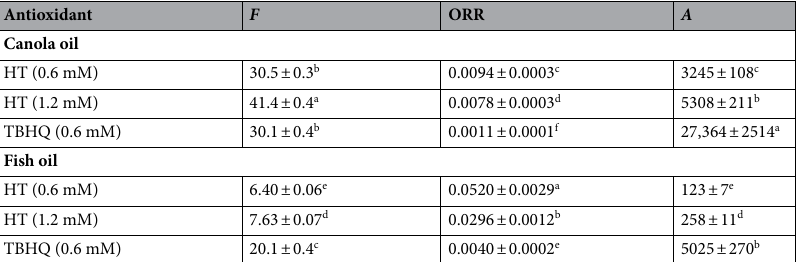
Table 3. The initiation kinetics of the inhibited peroxidation of the oil samples in the presence of hydroxytyrosol (HT) and tert -butylhydroquinone (TBHQ) at 60 °C. Means ± SD (standard deviation) within a column with the same lowercase letters are not significantly different at P < 0.05. F Stabilization factor, ORR oxidation rate ratio, A antioxidant activity.